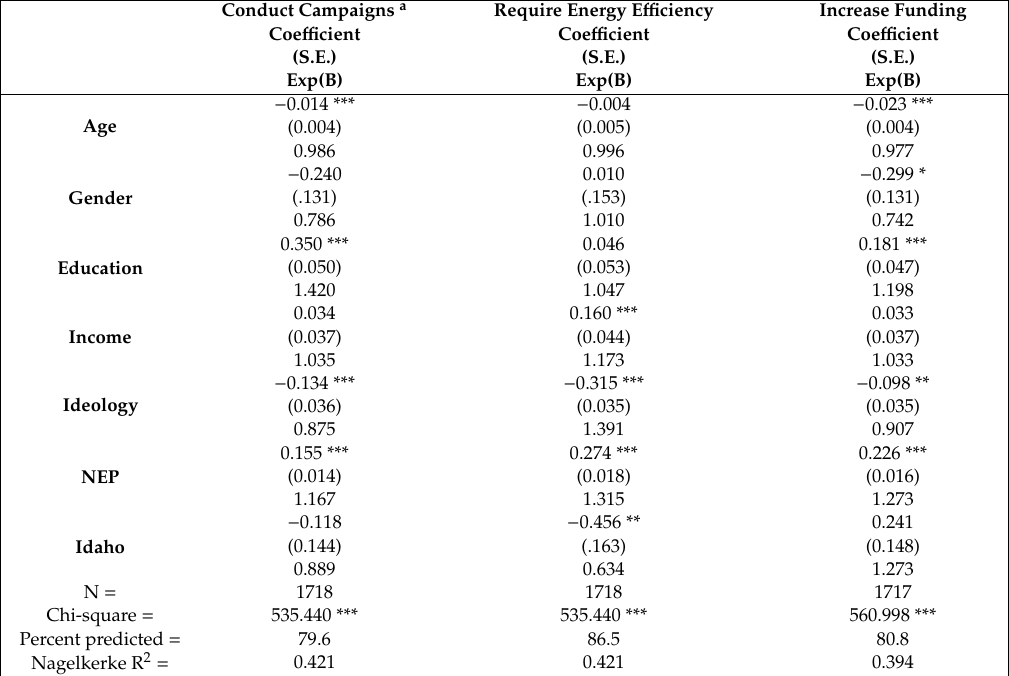
Table 6. Logistic Regression Estimates for Energy Conservation Policies. Conduct Campaigns a Require Energy E ffi ciency Increase Funding Coe ffi